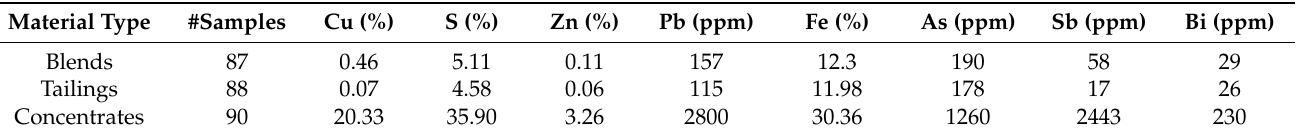
Table 1. Average chemical composition of the available samples. #Samples represents the number of XRD samples analyzed per each material